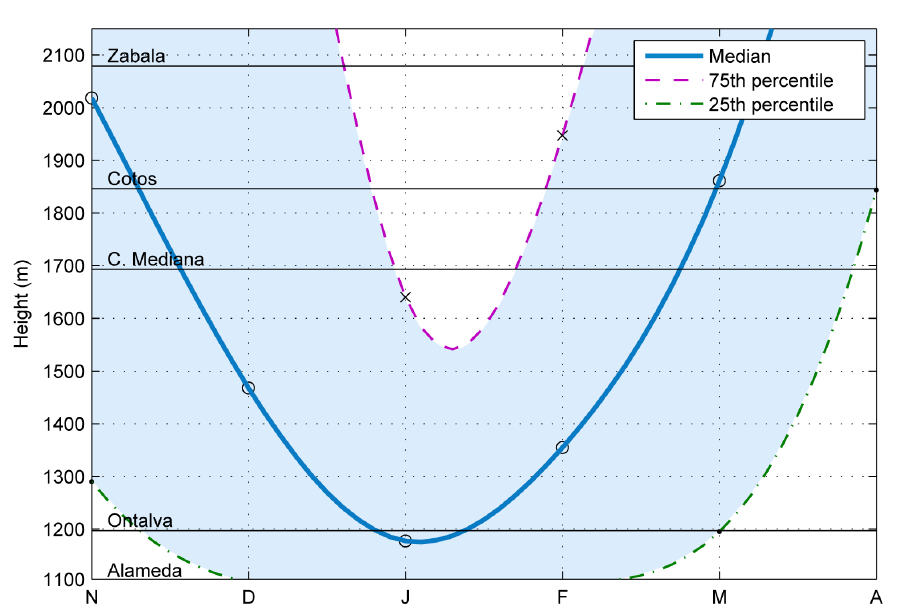
Figure 13. Median, 75th percentile and 25th percentile of elevations of the zero isotherm for winter months calculated out of the temperatures observed at all sites.